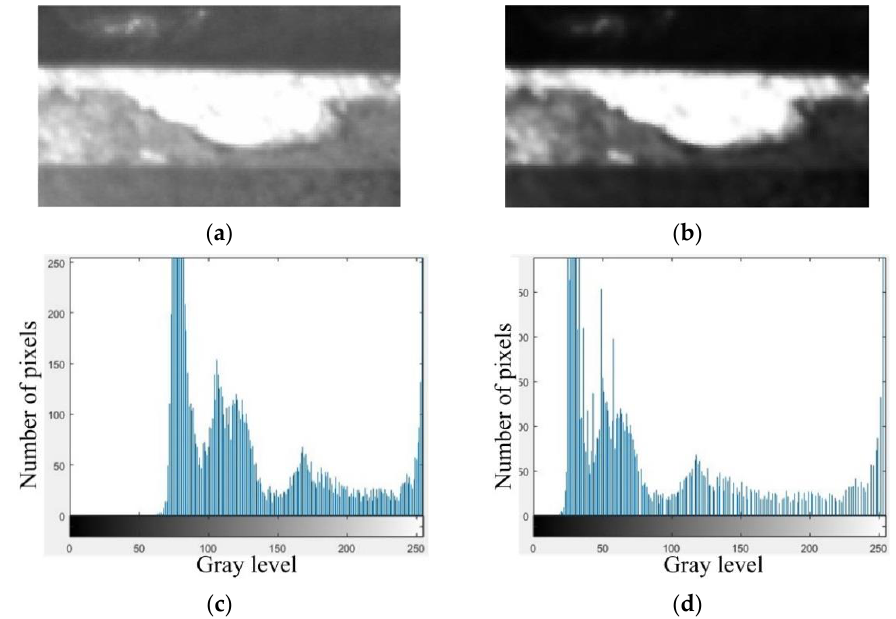
Figure 5. Images of flank wear before ( a ) and after ( b ) contrast enhancement. Gray level histograms that describe the number of pixels corresponding to all gray level values of images ( a , b ) are plotted in ( c , d ).